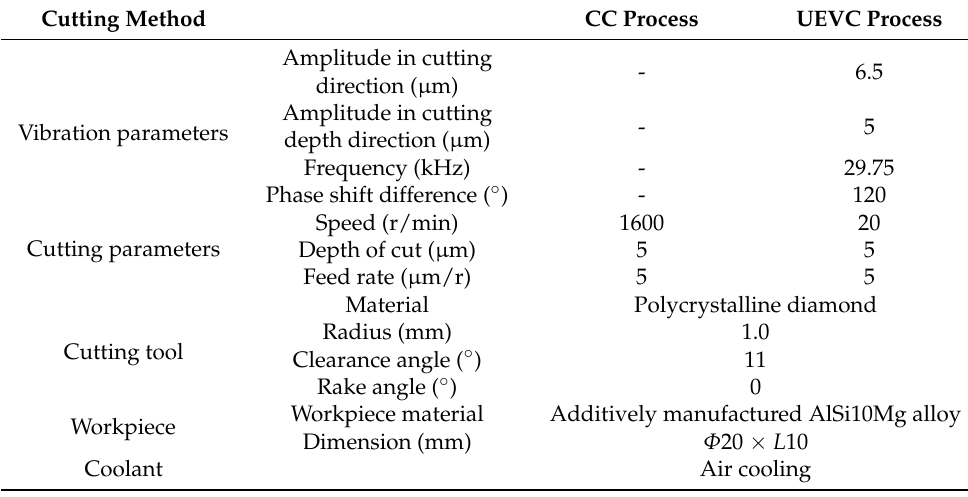
Table 1. Experimental conditions.